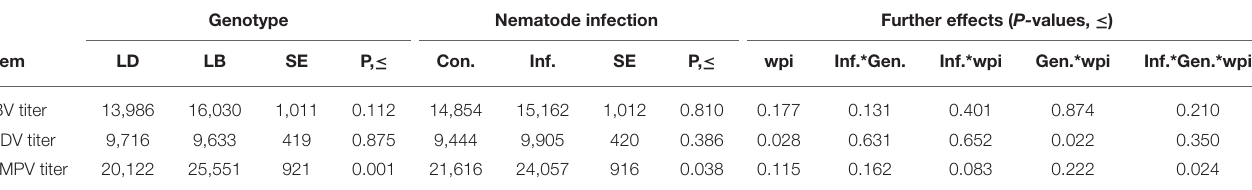
TABLE 3 | Vaccine-induced antibody levels against Infectious Bronchitis Virus (IBV), Newcastle Disease virus (NDV), and avian Metapneumovirus (AMVP) in laying hens in relation to host genotype and mixed-nematode infection. Genotype Nematode infection